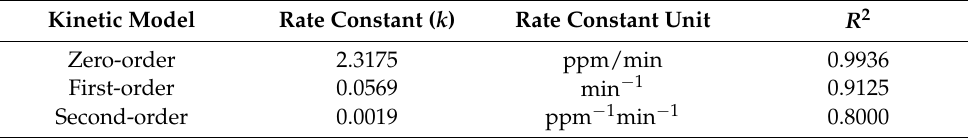
Table 2. Kinetic constants and R 2 calculated by different kinetic